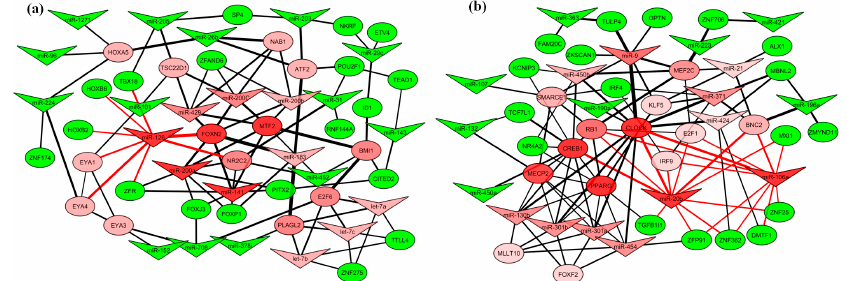
Figure 4. Common miRNA–transcription factor (TF) regulatory network between human and dog: ( a ) Regulatory network for down-regulated miRNAs and its up-regulated target TFs. MiR-126 influences eight TFs and has the highest centrality, ( b ) Regulatory network for up-regulated miRNAs and its down-regulated target TFs. MiR-20b and miR-106a have highest centralities. A miRNA (V-shaped) or TF (oval-shaped) is considered a node and line between nodes considered edge. Green and red indicate degree scores less and above than average and saturation shows deviation. Colour gradient of the nodes (miRNAs/mRNAs) indicates the strength of network regulation. Edge width represents edge betweenness. Node’s Edges with highest degree scores are in red.